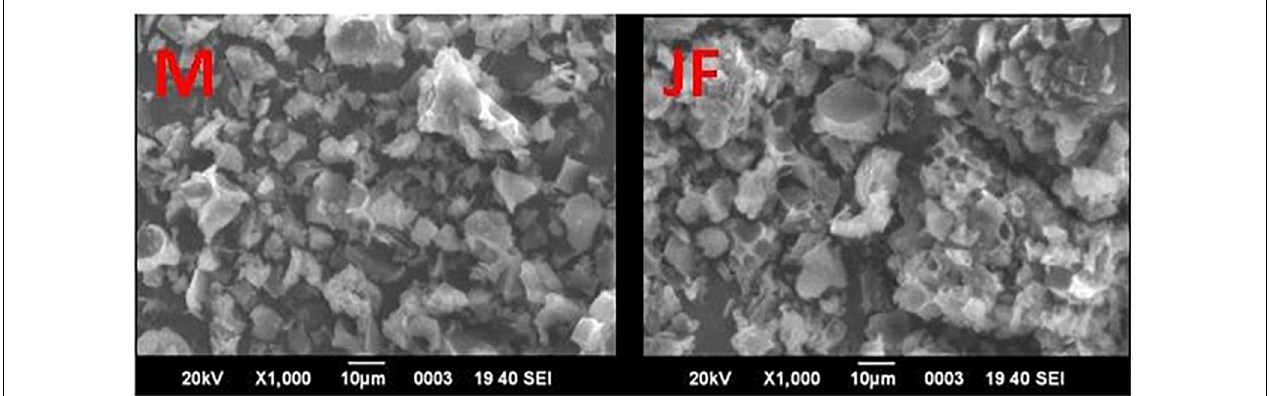
FIGURE 1 | SEM micrograph of bio-sorbent material of Mango (MF) and Jack fruit (JF) kernel biomass.